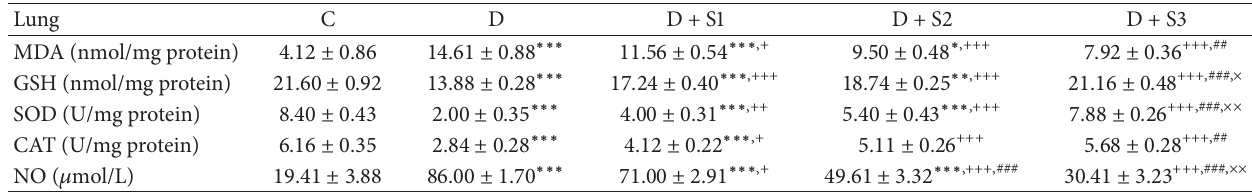
Each measurement has been done at least in triplicate and the values are the means ± SEM for eight rats in each group. Statistical significance for the difference between the data of control versus other groups: ∗ 𝑃 < 0.05 , ∗∗ 𝑃 < 0.01 , ∗∗∗ 𝑃 < 0.001 . Statistical significance for the difference between the data of diabetes versus treated groups: + 𝑃 < 0.05 , ++ 𝑃 < 0.01 , +++ 𝑃 < 0.001 . Statistical significance for the difference between the data D + S1 versus D + S2 and D + S3 ( ## 𝑃 < 0.01 , ### 𝑃 < 0.001 ). Statistical significance for the difference between the data between D + S2 versus D + S3 ( × 𝑃 < 0.05 , ×× 𝑃 < 0.01